Question: In a single sentence, describe what this figure presents.
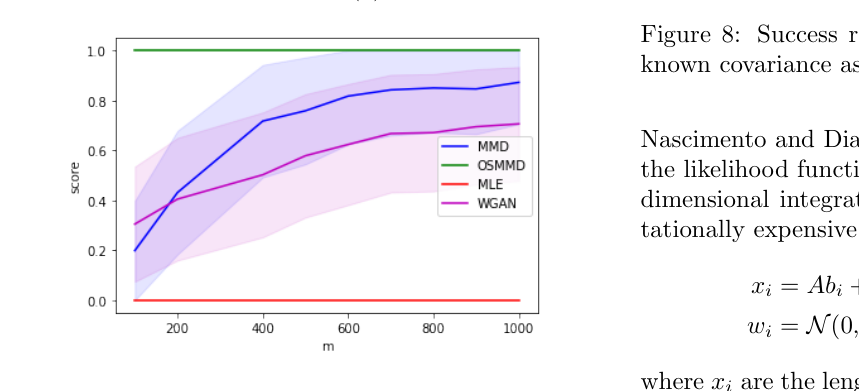
Answer: Success rate in a Gaussian model with un- known covariance as a function of m.